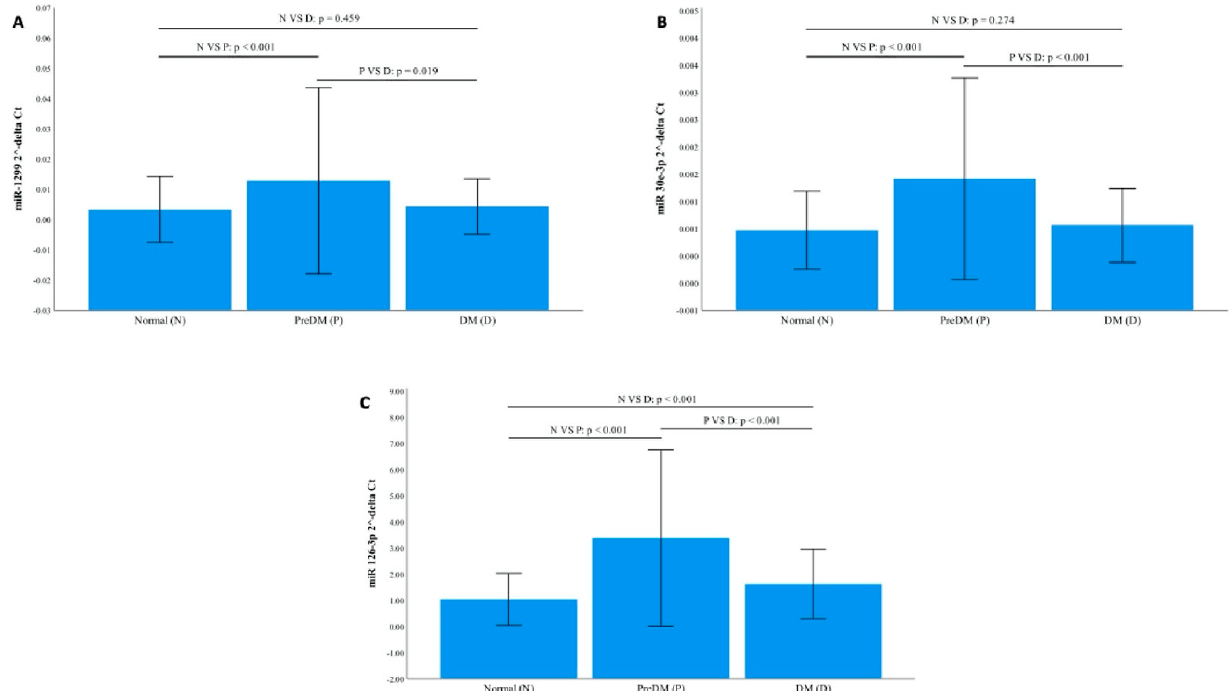
Figure 1. Relative Expression of miR-1299, miR-30e-3p and miR-126-3p according to glycaemic status. The expression of the microRNAs (miRNAs) was normalised to the relative expression of miR-16-5p. ( A ): miR-1299. ( B ): miR-30e-3p. ( C ): miR-126-3p. Data are shown as mean ± SD. n , normotolerant; D, diabetes; p , prediabetes. Table 2. Fold change analysis, 2 −ΔΔ Ct between the glucose tolerance groups. MicroRNA Prediabetes vs. NGT DM vs. NGT